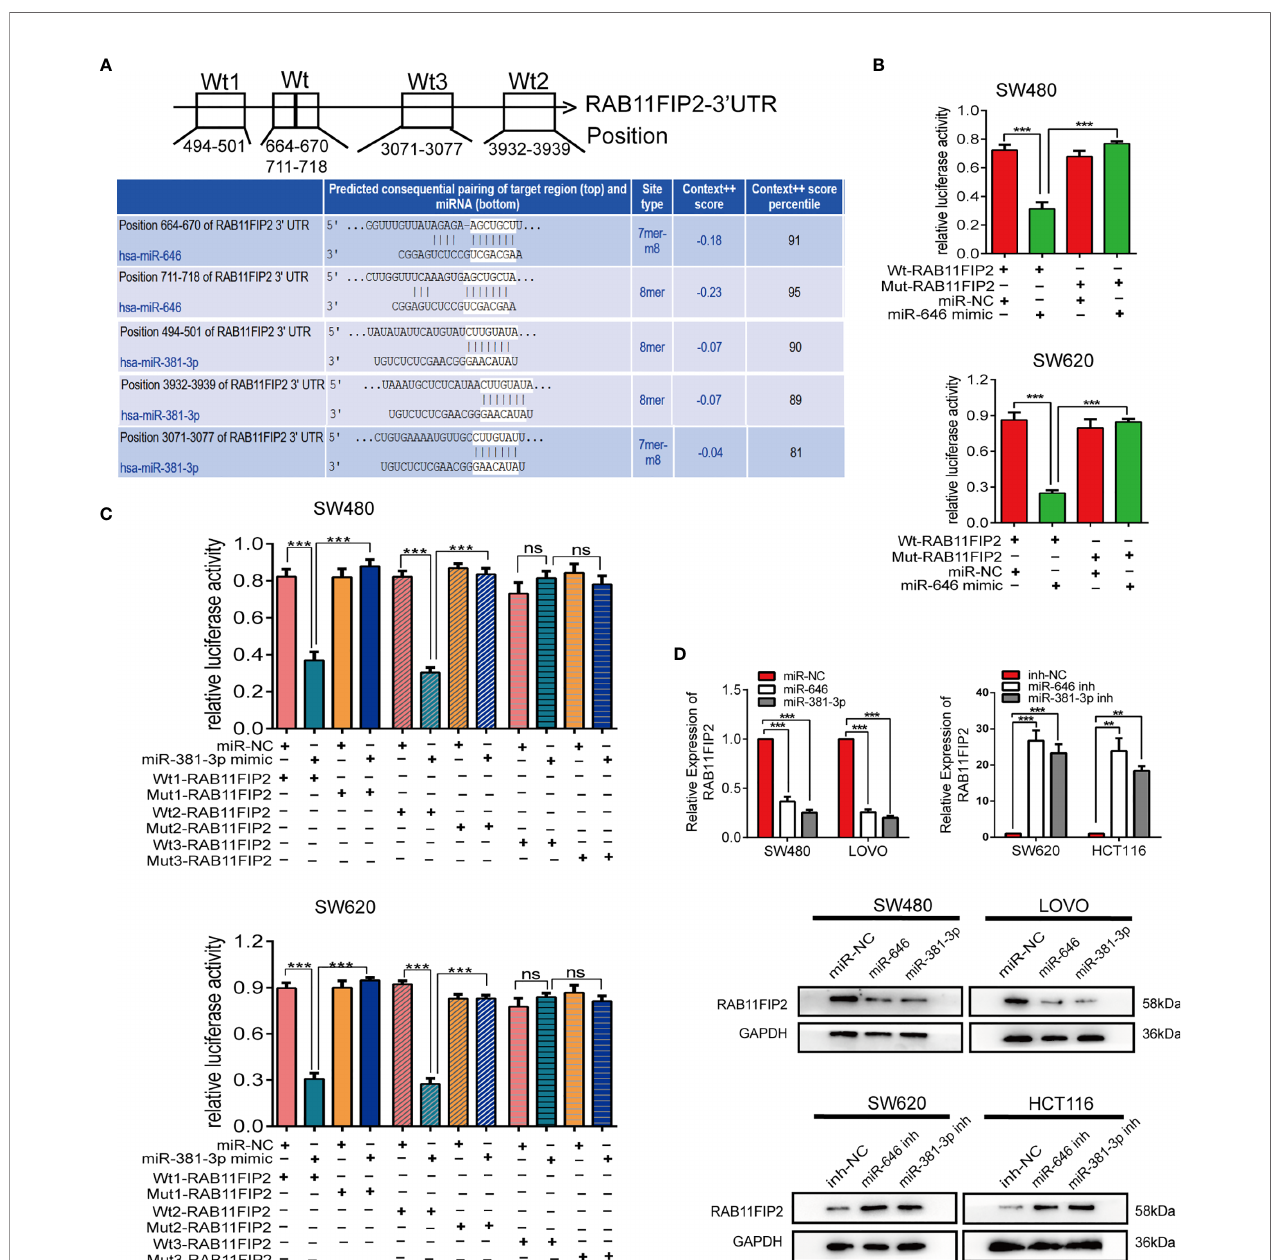
FIGURE 4 | miR-646 and miR-381-3p co-target and negatively regulate RAB11FIP2. (A) Predicted binding sites of miR-646 and miR-381-3p on the RAB11FIP2 3 ’ UTR sequence. The white nucleotides are the seed sequences of miR-646 and miR-381-3p. (B, C) Luciferase activities were measured in CRC cells co- transfected with a luciferase reporter containing the wild-type RAB11FIP2 3 ’ UTR and miR-646 and miR-381-3p mimics or the mutant RAB11FIP2 3 ’ UTR. Data are presented as the relative ratio of Renilla luciferase activity and fi re fl y luciferase activity. (D) The relative expression levels of RAB11FIP2 in CRC cells transfected with miR-646 and miR-381-3p mimics or inhibitors were determined by qRT-PCR and WB. Error bars represent the means ± SD of 3 independent experiments. ns, no signi fi cance; ** p < 0.01; *** p